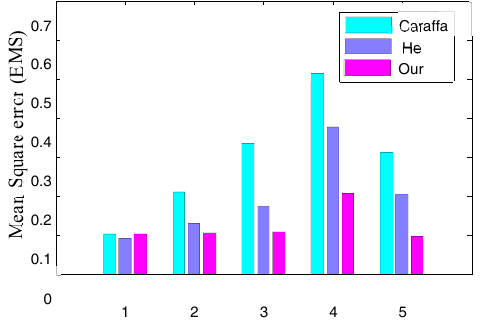
Figure 11. Mean Square Error (MSE).